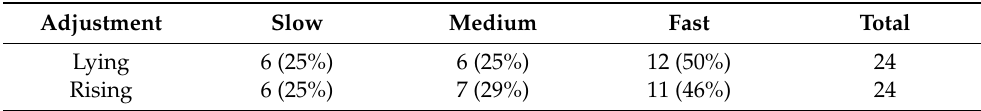
Table 4. The numbers and percentages of subjects reporting their preference for the adjust- ment speeds.